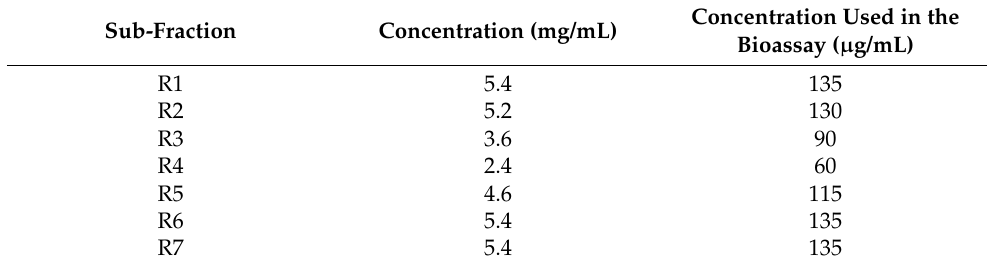
Table 4. Sub-fractions obtained from the fraction E35-DF. We found that all the sub-fractions were active against C. glabrata and C. albicans, with the sub-fractions R2, R3, R4 and R5 exceling in terms of antifungal efficacy at the concentrations assayed (Figure 6 and Table